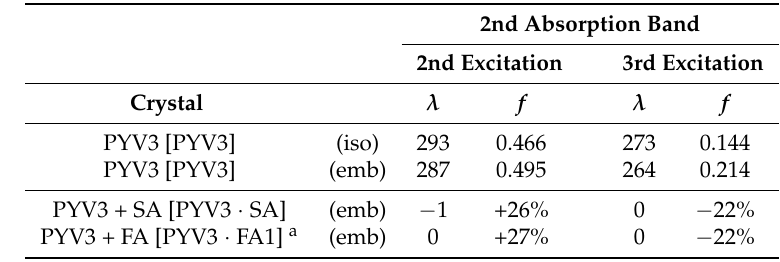
Table A9. RI-CC2/def2-TZVPD wavelengths of excitation ( λ , in nm) and oscillator strengths ( f ) for the keto forms of the isolated and embedded PYV3 (PYV3 [PYV3]) and the embedded heteromers of its co-crystals (PYV3 + XXX [PYV3 · XXX]). For PYV3 [PYV3], the absolute values are given while